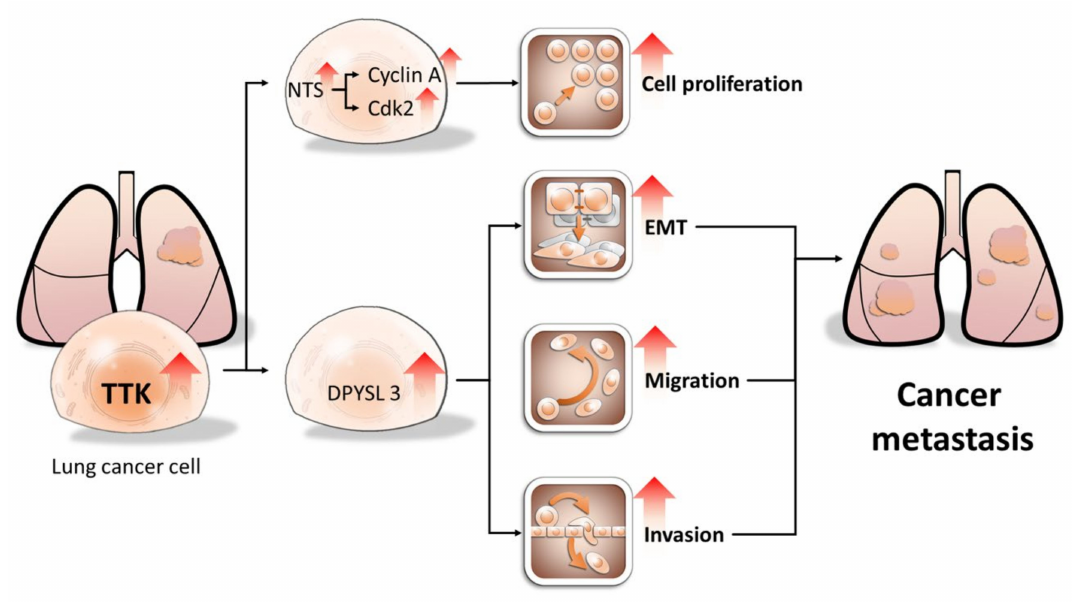
Figure 8. Proposed model of TTK oncogenic potential in lung cancer. TTK increases cell proliferation by enhancing NTS expression, which in turn elevates cyclin A and CDK2 expression. In contrast, TTK promote cancer metastasis by causing EMT in a DPYSL3-dependent manner. Our study may provide novel target for developing personalized diagnostics and therapeutic strategy for lung cancer patients. The arrows mean up-regulation of levels of specific genes and cellular